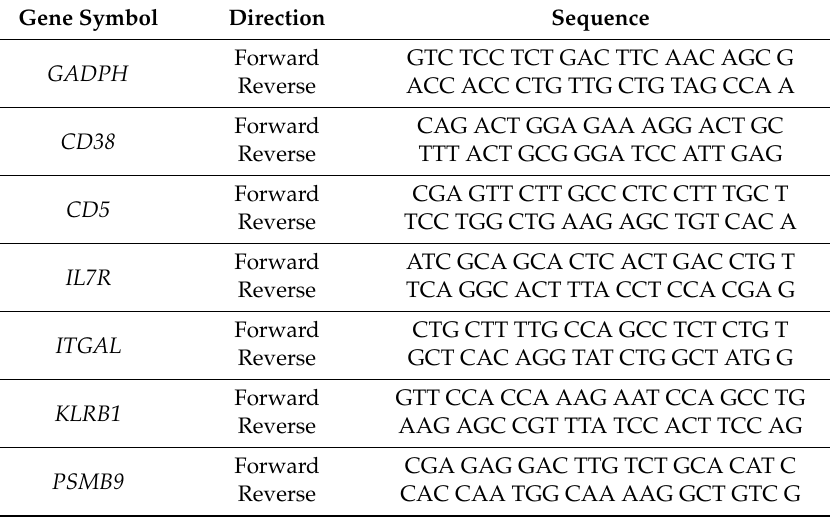
Table 2. List of primers used in this